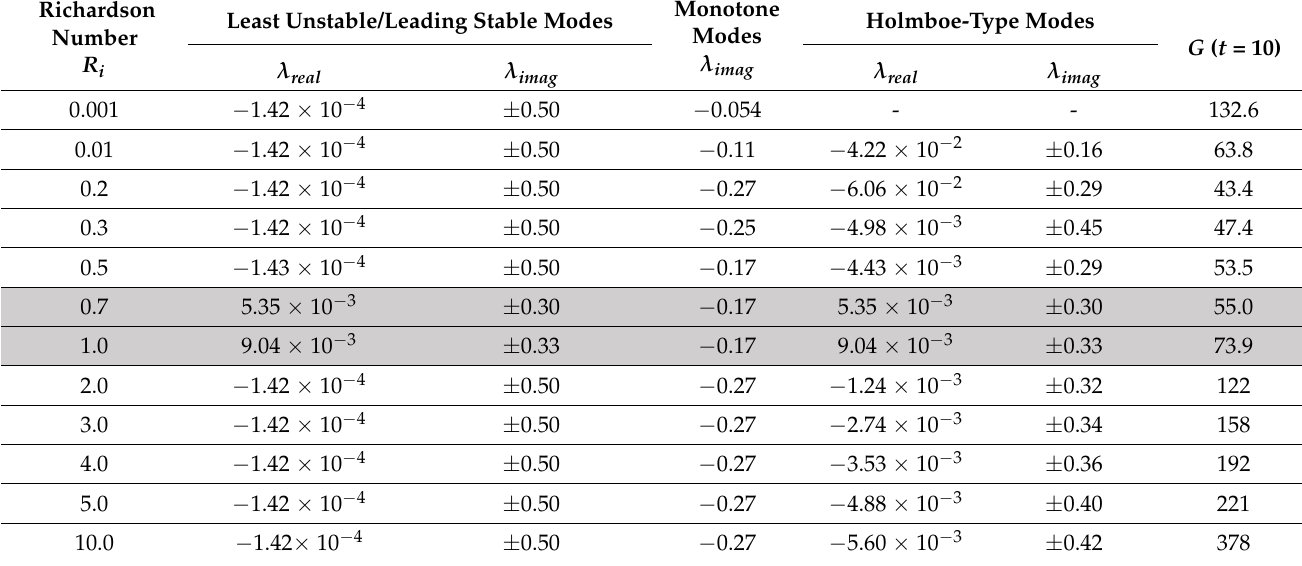
Table 4. The leading eigenvalues, leading monotone and oscillatory (KH-, Holmboe-type) modes, and values of growth function, G , at t = 10 for the increasing Richardson number at α = 0.5, β = 1, Re = 1000 (3D case). The linearly unstable range is denoted by the gray